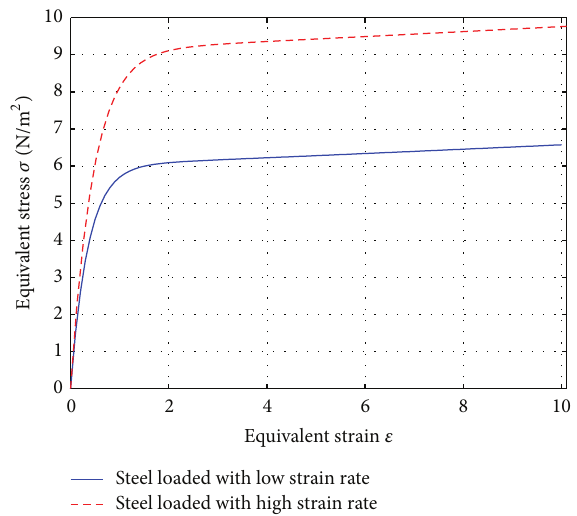
Figure 9: Constitutive relation of steels with different strain rate based on approximate solutions.